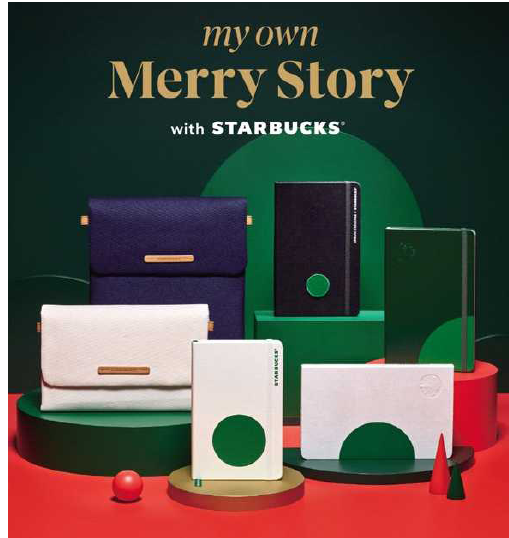
Figure 24. Starbucks 2021 Diary [74].